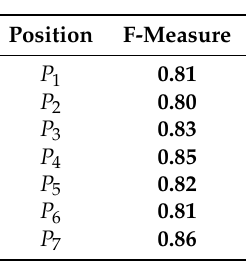
Table 7. F-measure of position-dependent and subject-independent HAR for this work over all seven positions.